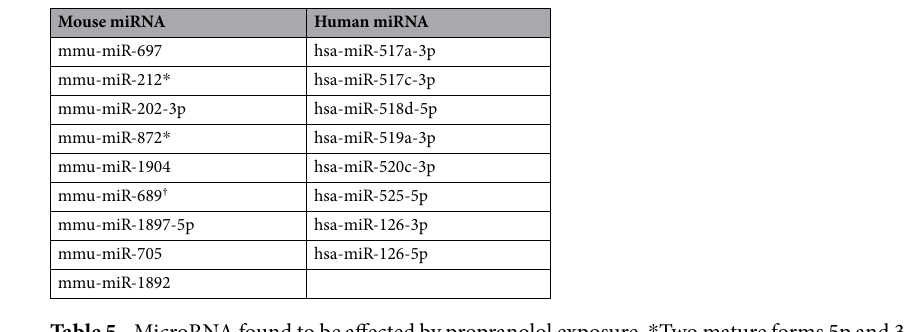
Table 5. MicroRNA found to be affected by propranolol exposure. * Two mature forms 5p and 3p. † Dead entry on miRbase database, and thus not considered for